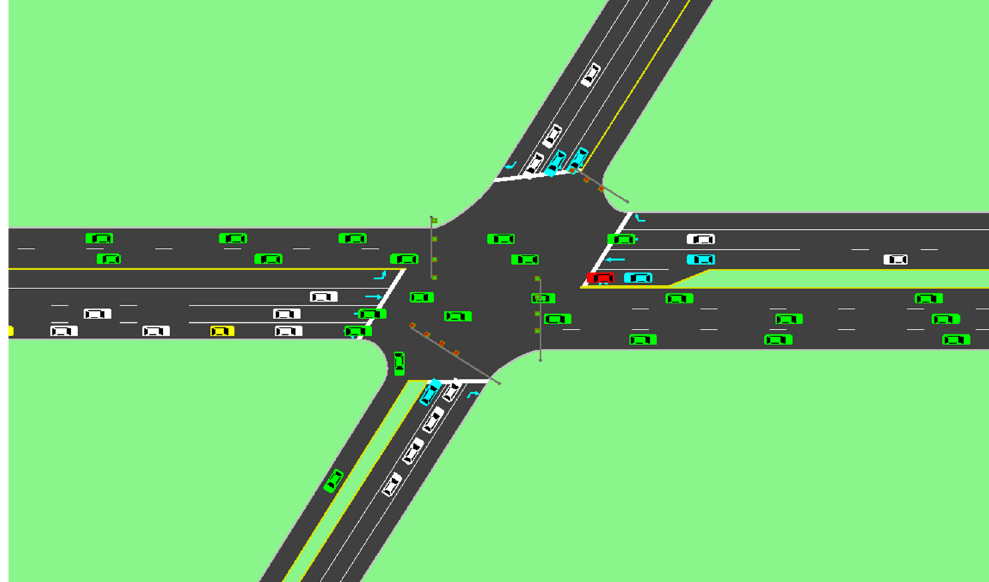
Figure 11. Model of intersection No. 3 in Synchro 7 and SimTraffic.